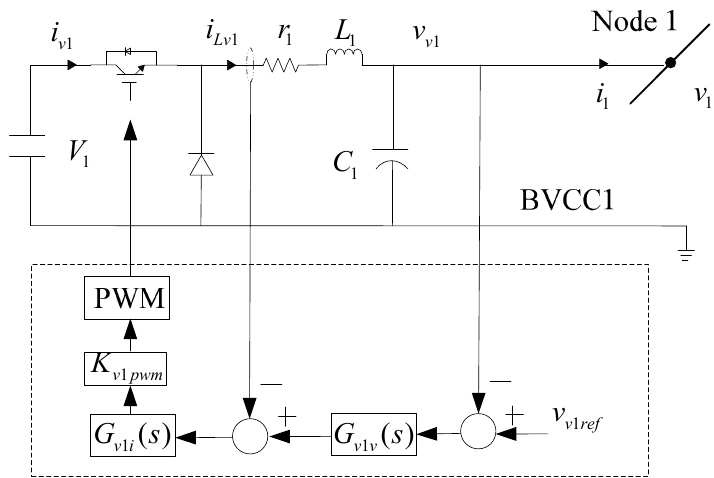
G and G and 1 v v 1 v v